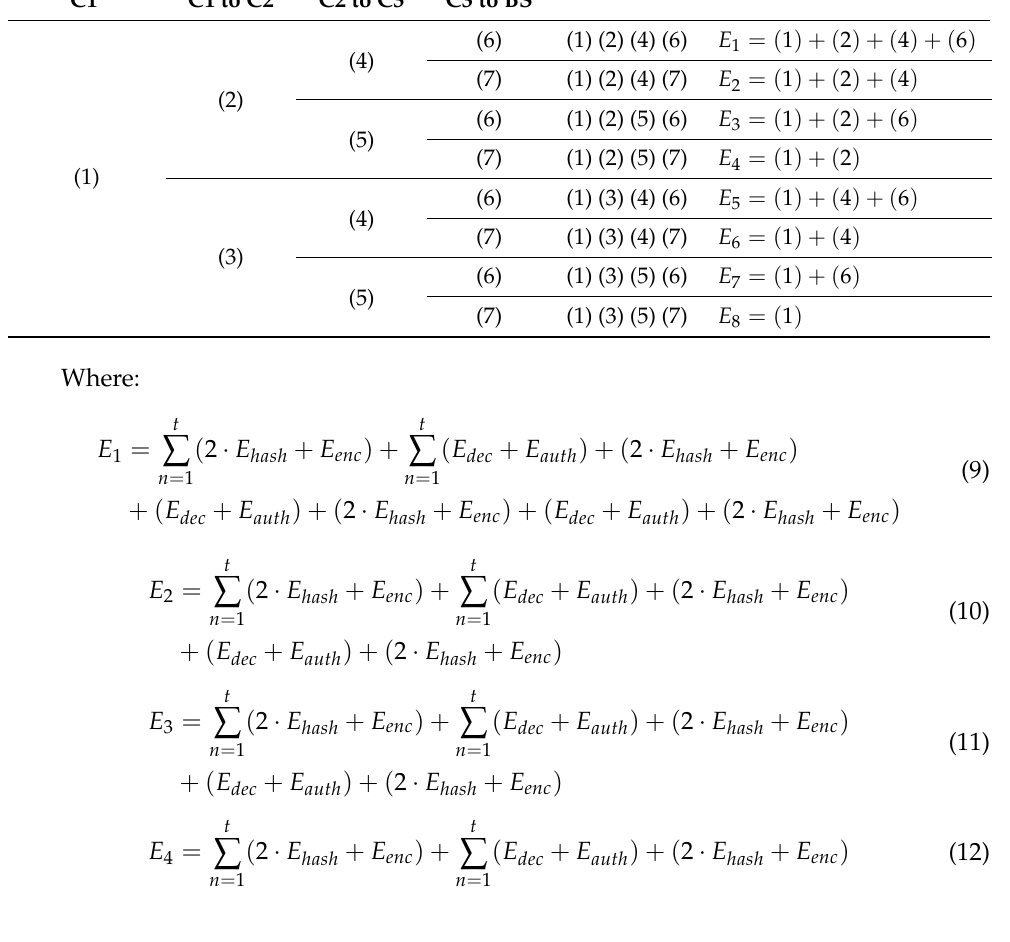
Table 1 highlights the required amount of energy to send messages from cluster1 to the base station based on Figure 1 in various configurations ( E 1–8 ). The overall consumption of energy in the network includes energy costs generated by clusters 2, 3, and 4. Table 1. Extra consumed energy evaluation to secure MHA-CS. Node to CH CH to CH CH to CH CH to